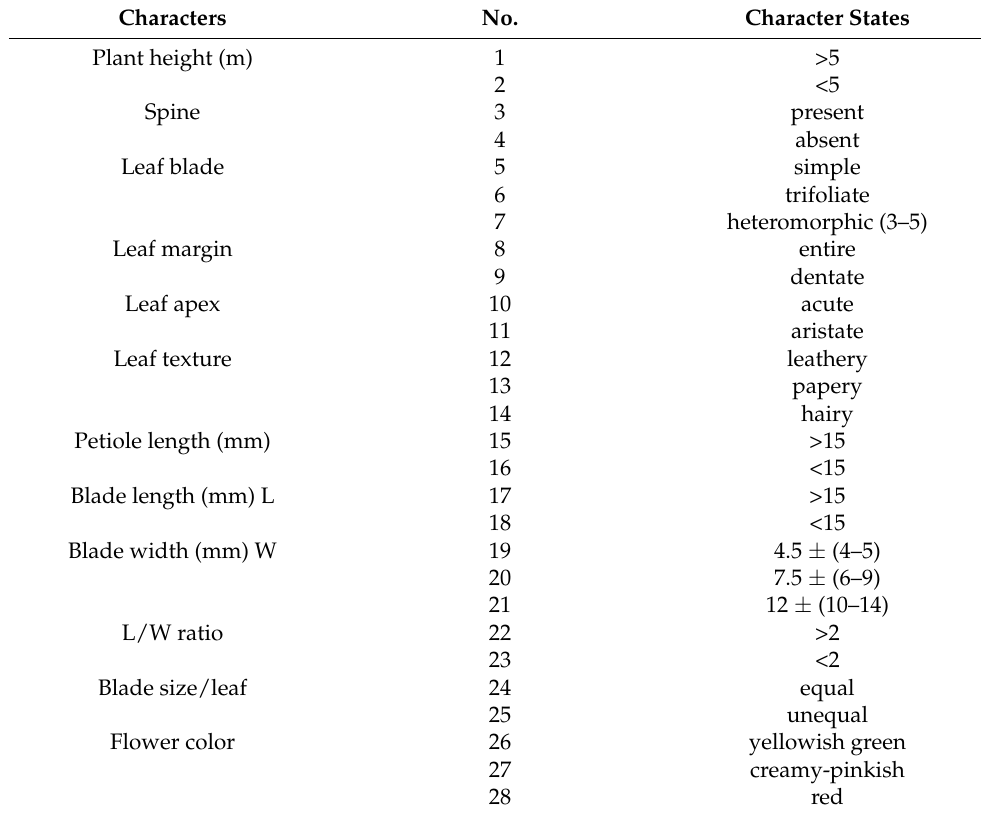
Table 2. The character list used for the description of Commiphora species morphologically. Characters No. Character States Plant height